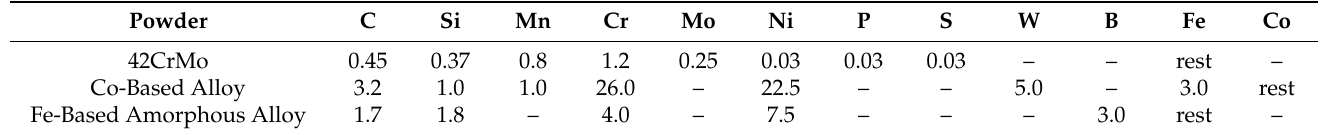
Table 1. Chemical composition (wt.%) of the raw